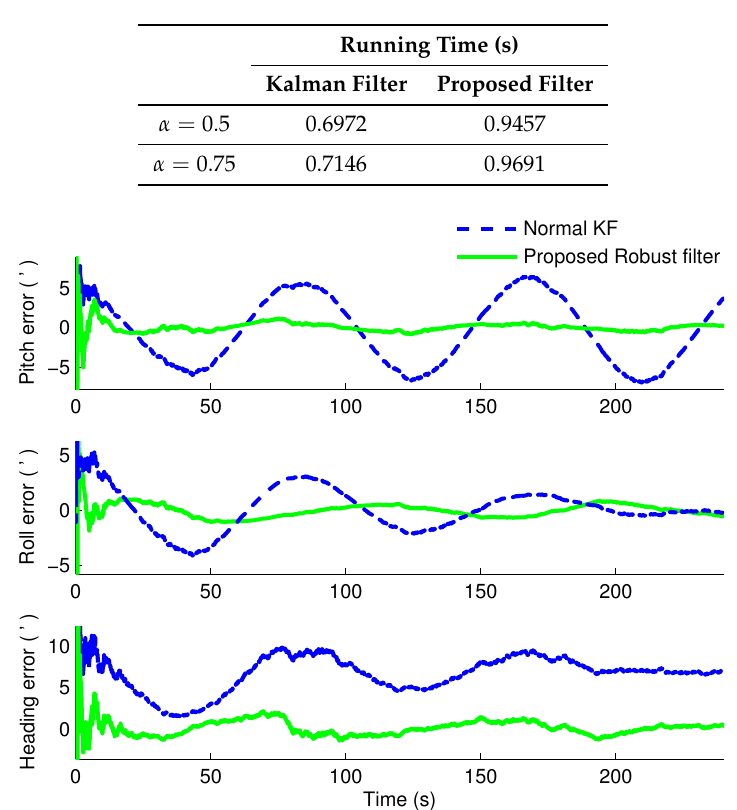
Figure 3. The estimated errors of the misalignment angles when α =